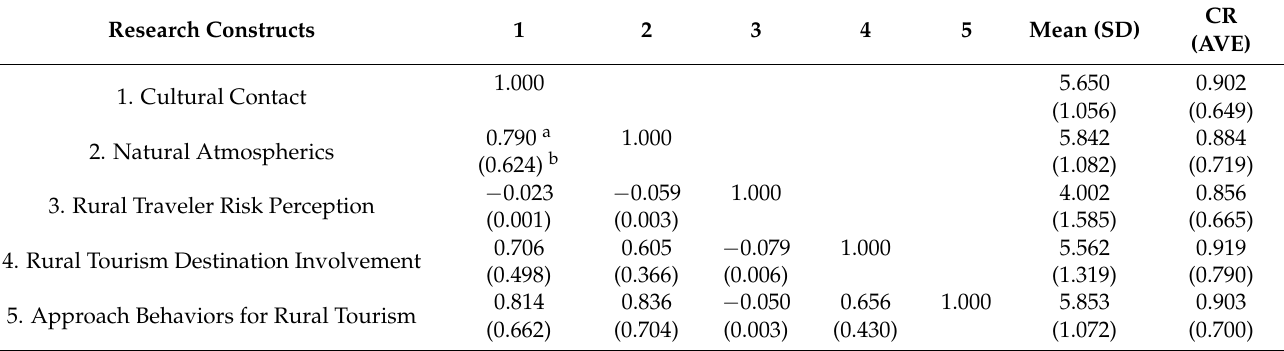
Table 3. Result of the data quality testing ( n =